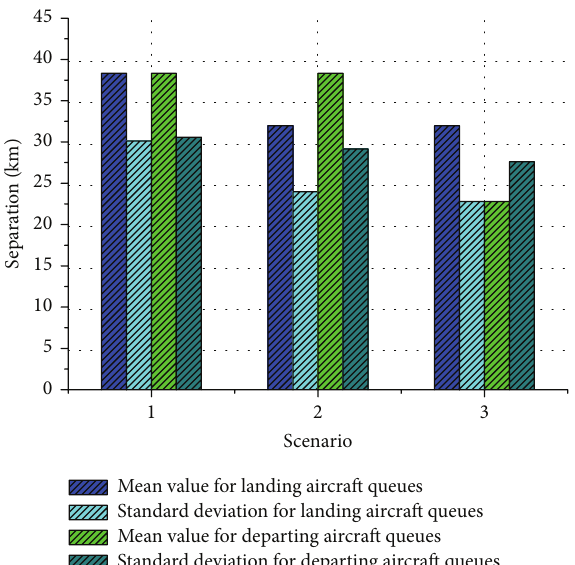
Figure 20: Statistics of separation for three scenarios.